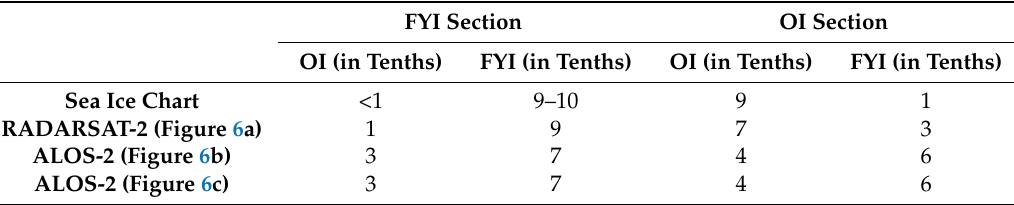
Table 6. Sea ice concentrations in the FYI and OI sections and ice chart shown in Figure 6a–c. FYI Section OI Section OI (in Tenths) FYI (in Tenths) OI (in Tenths) FYI (in Tenths) Sea Ice Chart <1 9–10 9 1 RADARSAT-2 (Figure 6a) 1 9 7 3 ALOS-2 (Figure 6b) 3 7 4 6 ALOS-2 (Figure 6c) 3 7 4